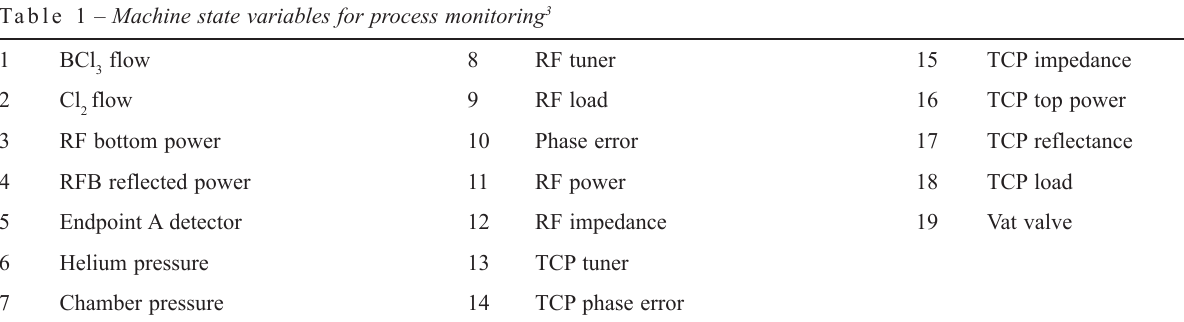
Table 1 – Machine state variables for process monitoring 3